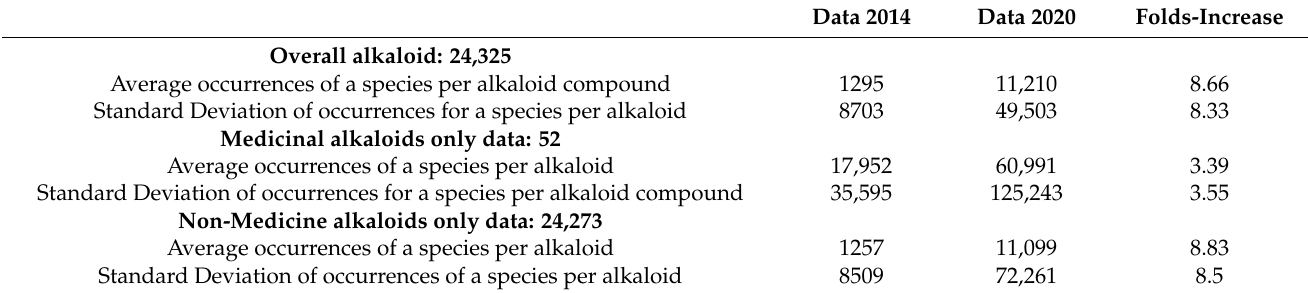
Table 1. Comparison of GBIF occurrence for species containing alkaloids—2014 and 2020 (Summary